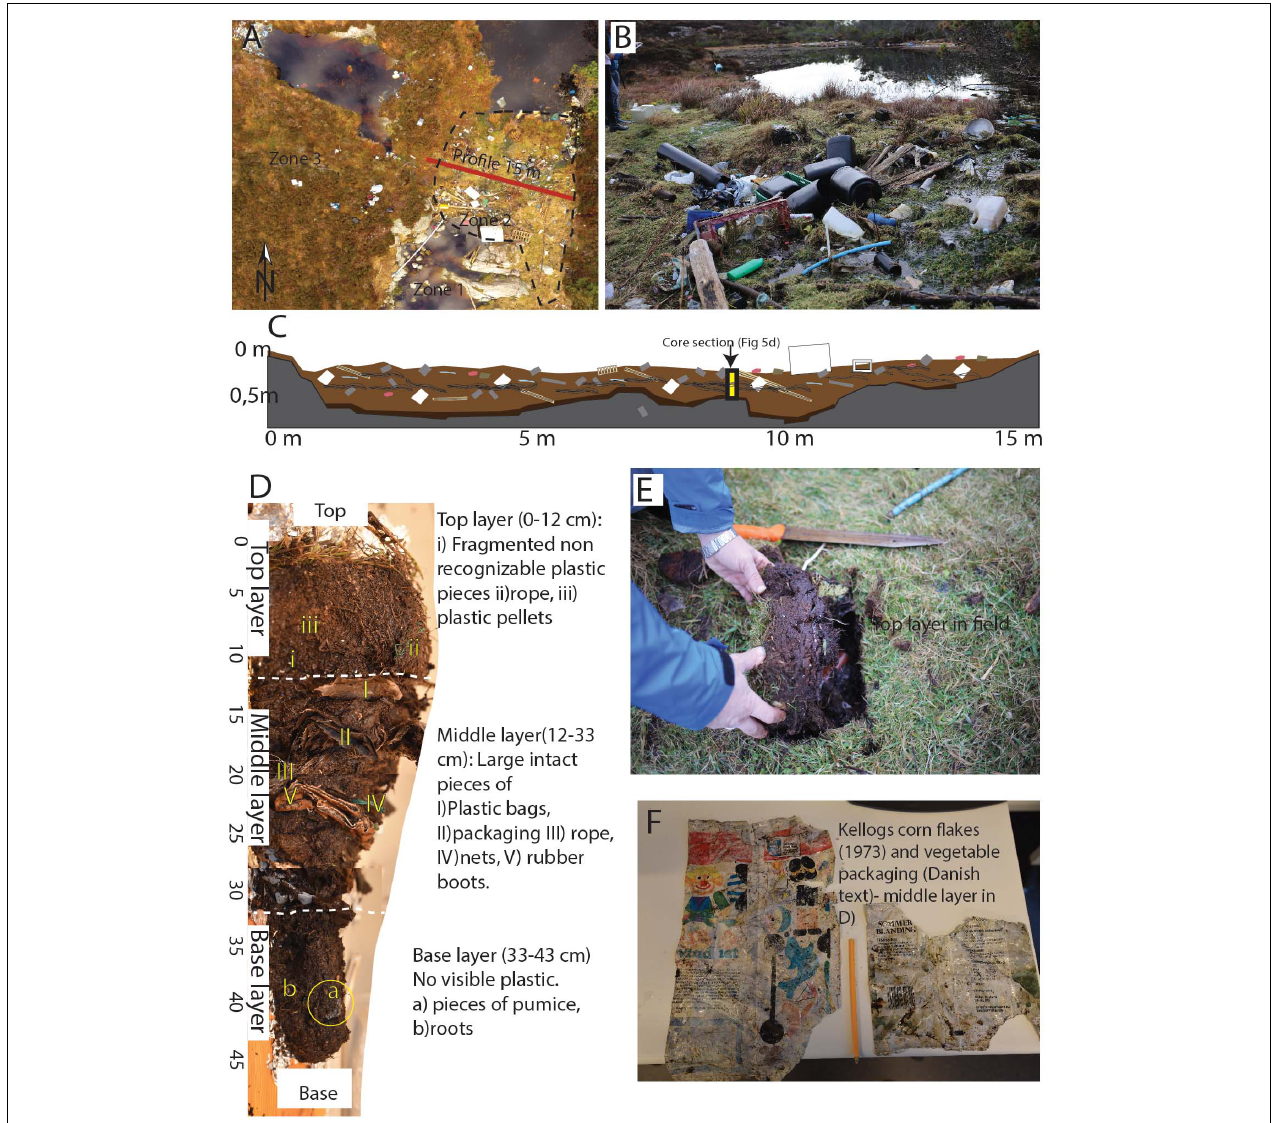
FIGURE 2 | (A) Drone photo of the Zone 2 embankment that limits the pond from Zone 1. The profile that was used for measuring depth to basement rocks is denoted. (B) Close up image showing the type and amount of marine litter on the surface. Note the water saturated surface and water protruding from the pond in Zone 3. (C) Illustration of the depth profile through the embankment. Colored items illustrate plastic fragments of various sizes and types. (D) Photo of core taken in central part of the storm embankment. Various items observed on the surface are denoted. Upper part comprises small fragmented plastic pieces embedded in black organic rich soil, middle part consists of large and preserved marine litter, lower part consists of a base soil layer free from plastic. Colored pieces represent pumice that may be of volcanic origin. (E) Coring technique by using a serrated knife. (F) Pieces of preserved packaging plastic found in the middle part of the core. The Kellogg’s cornflakes packaging is dated